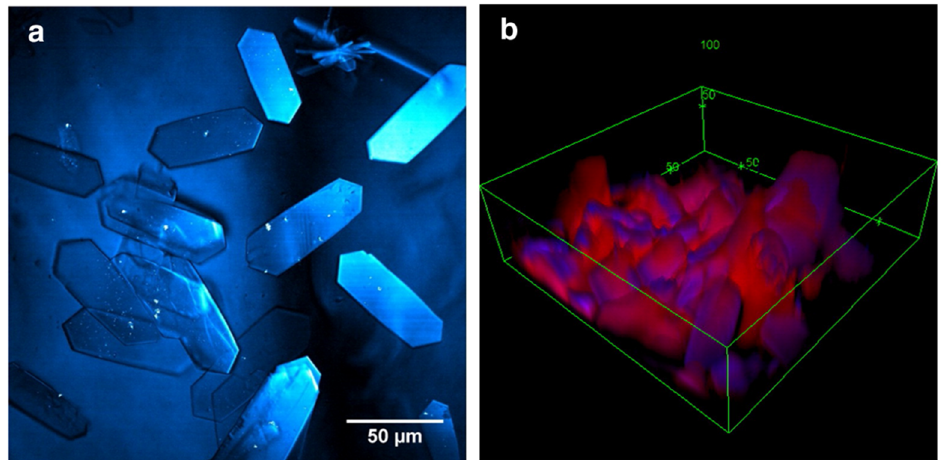
Figure 1. Crystals of Ibuprofen-d3 formed after 30 min of application onto the skin; ( a ) topology of the crystals on the skin; ( b ) 3D representation in which ibuprofen represented in blue and skin lipids false-colored in red (figures reproduced with permission from Belsey and associates [28].